Question: Identify the chart type used in this figure.
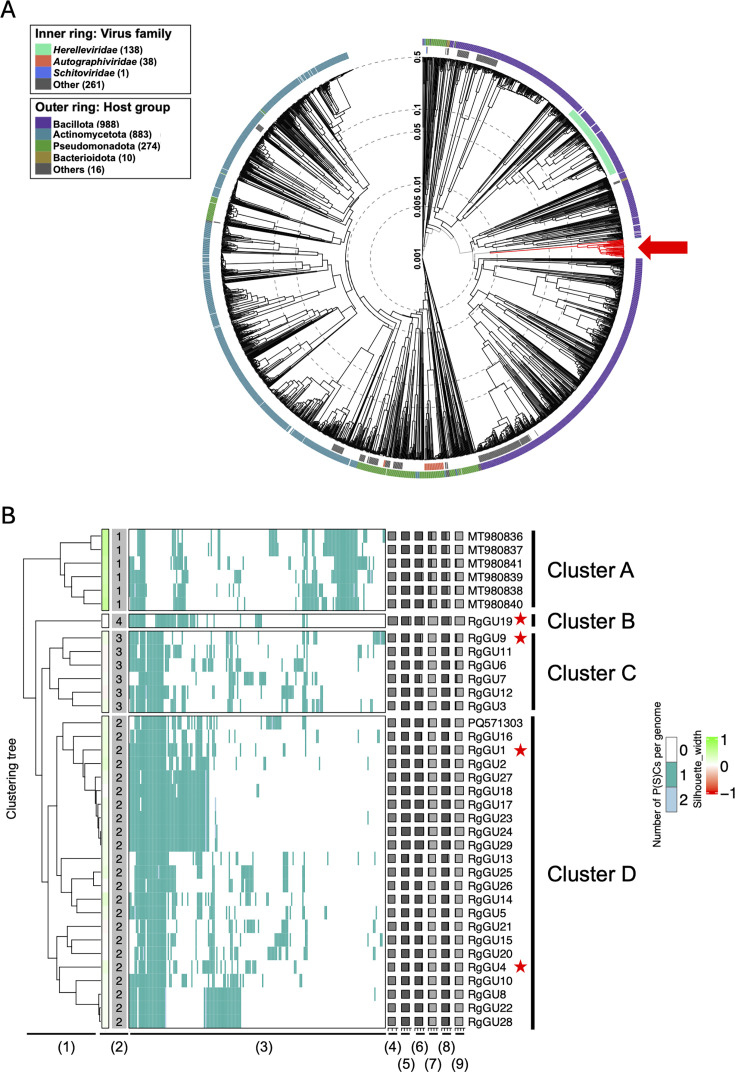
Answer: heatmap